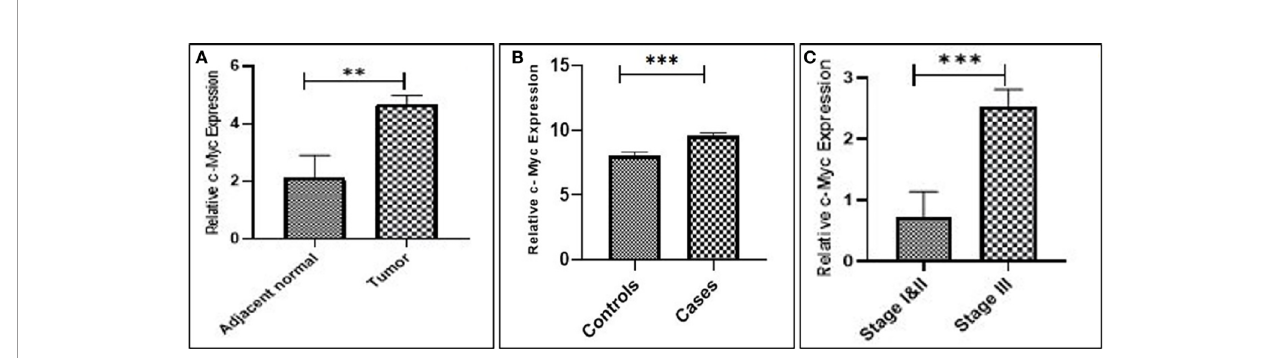
FIGURE 1 | Upregulation of c-Myc expression in gastric cancer. (A) Tissue. (B) Blood. (C) Stage III compared to stages I and